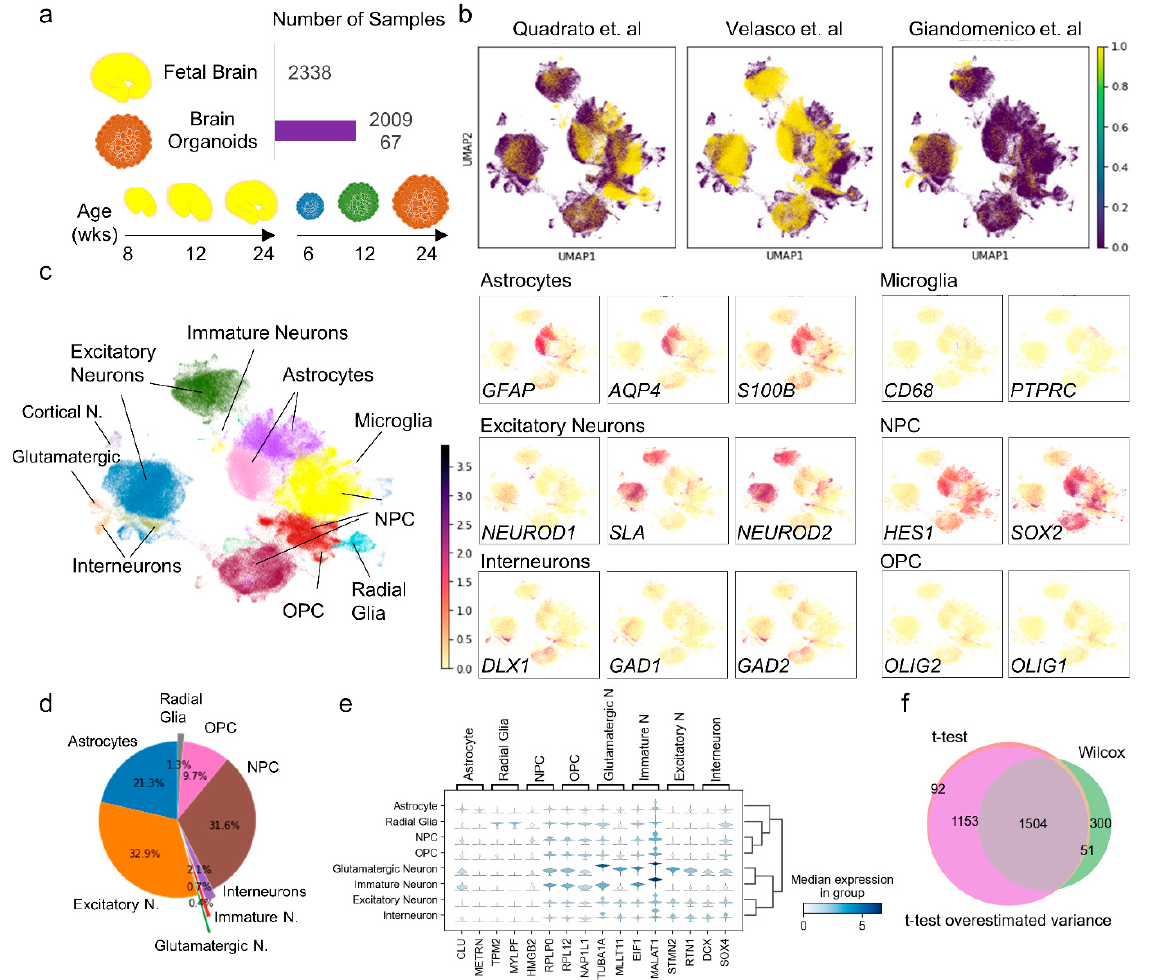
Figure 1. Visualization of integrated dataset from organoid and fetal brain samples highlighting differences in cellular repertoire. ( a ) Schematic showing organoids (blue, green and brown) and fetal brain (yellow) samples and the timepoint of dissociation before scRNA ‐ seq ( b ) Visualization of single cells on the integrated dataset and separated by organoid generation protocols. Each dot represents one single cell and colored purple for the integrated dataset, and yellow for each organoid generation protocol. ( c ) Annotation of 3D UMAP by major cell types and cell type ‐ specific markers used in identifying cluster identities. ( d ) Fraction of cells from each major cell ‐ type in the overall dataset. Excitatory neurons are the most abundant cell type followed by astrocytes. Immature neurons and glutamatergic neurons comprise < 1% of cells. ( e ) Violin plots showing expression of top two differentially expressed markers for each major cell type using Wilcoxon method. ( f ) Differential expression for identification of cell ‐ type ‐ specific markers was performed with three methods, Wilconxon, t ‐ test, t ‐ test overestimated variance. The identified markers genes showed close overlap across different methods.